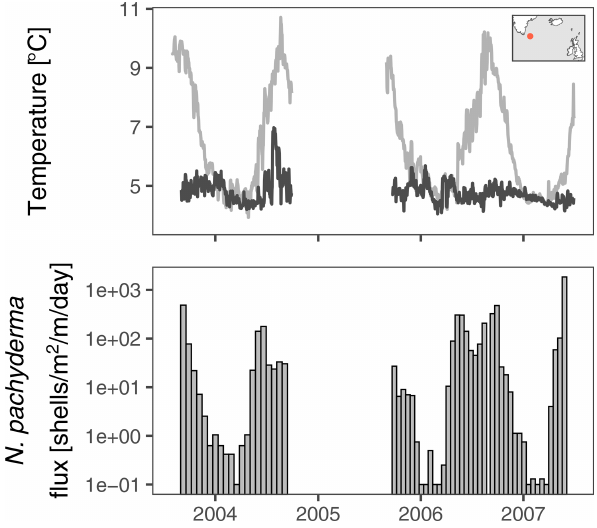
Figure 1. Temperature at the surface and at 200–250m water depth at the Irminger Sea sediment trap mooring (red dot in map inset). In winter and spring the water column is mixed to great depths. The bottom panel shows the evolution of the shell flux of N. pachyderma (150–250µm from Jonkers et al. (2010); zero fluxes are shown as 0.1shellsm − 2 d − 1 ); stable isotope data are available for all but the lowest flux intervals (Fig. 2). No data are available for the deploy- ment from 2004 to 2005 because of failure of the sediment